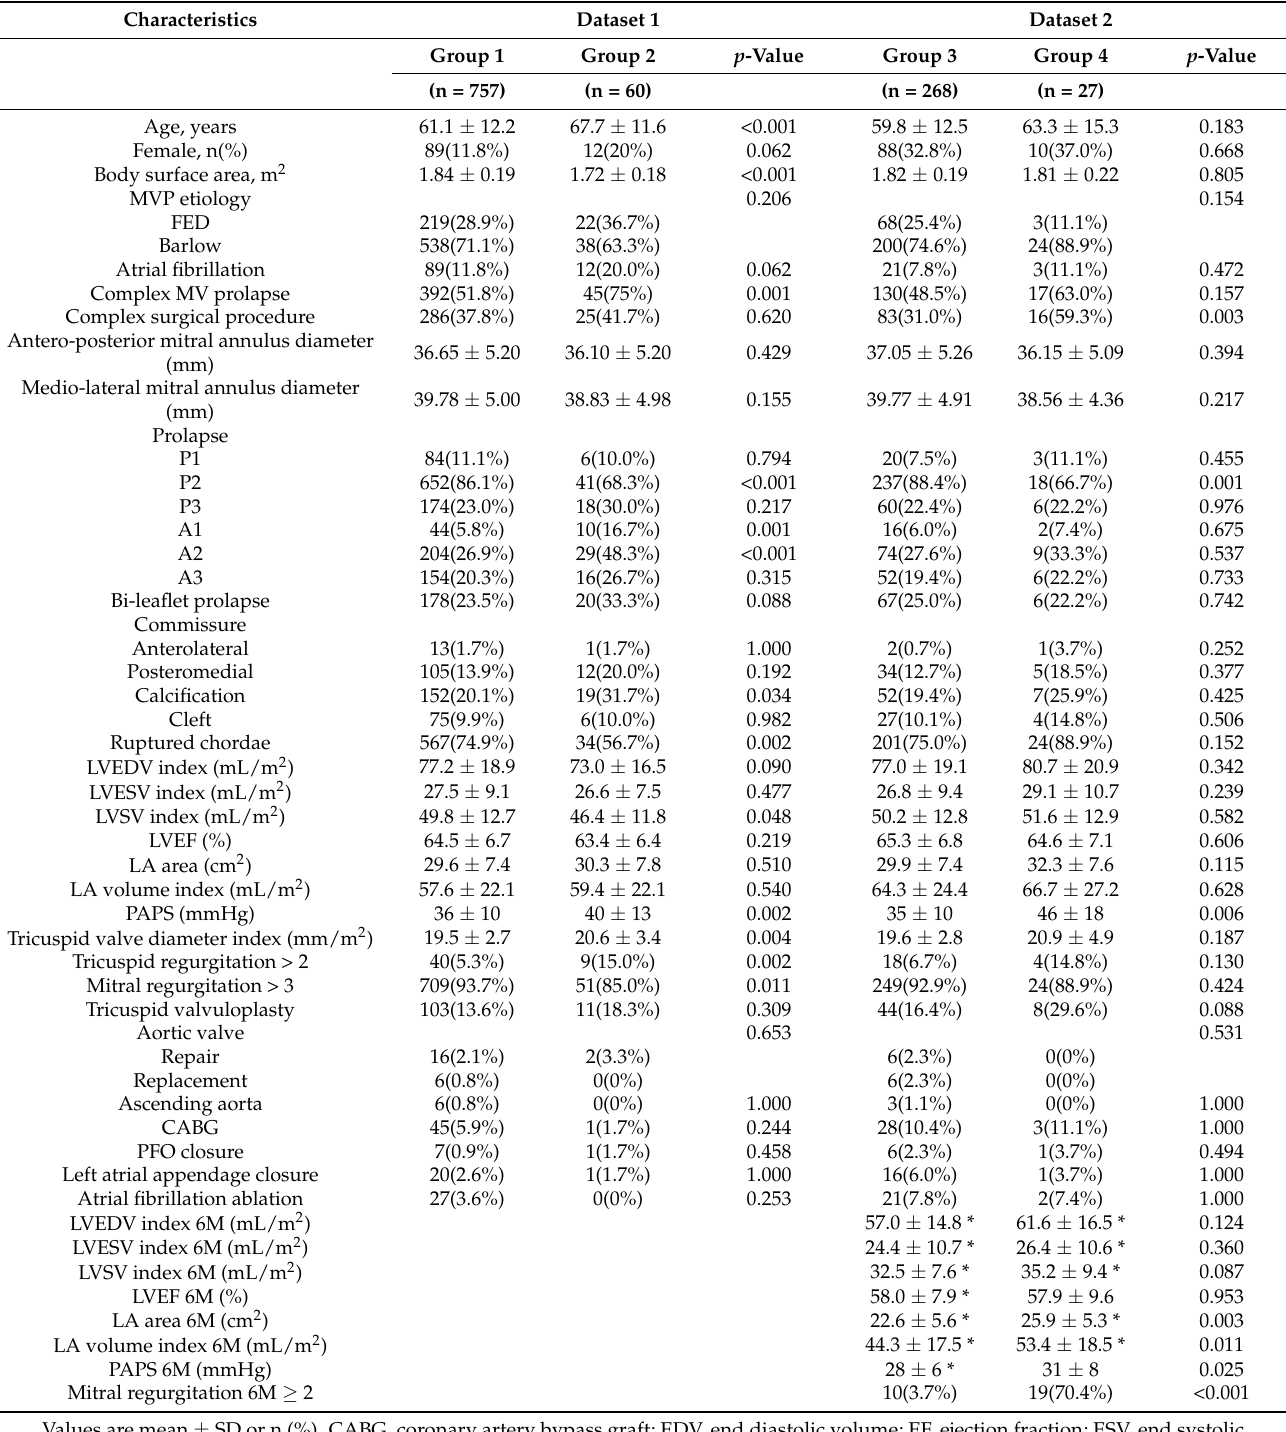
Table 2. Clinical, procedural, and echocardiographic characteristics of the study population.